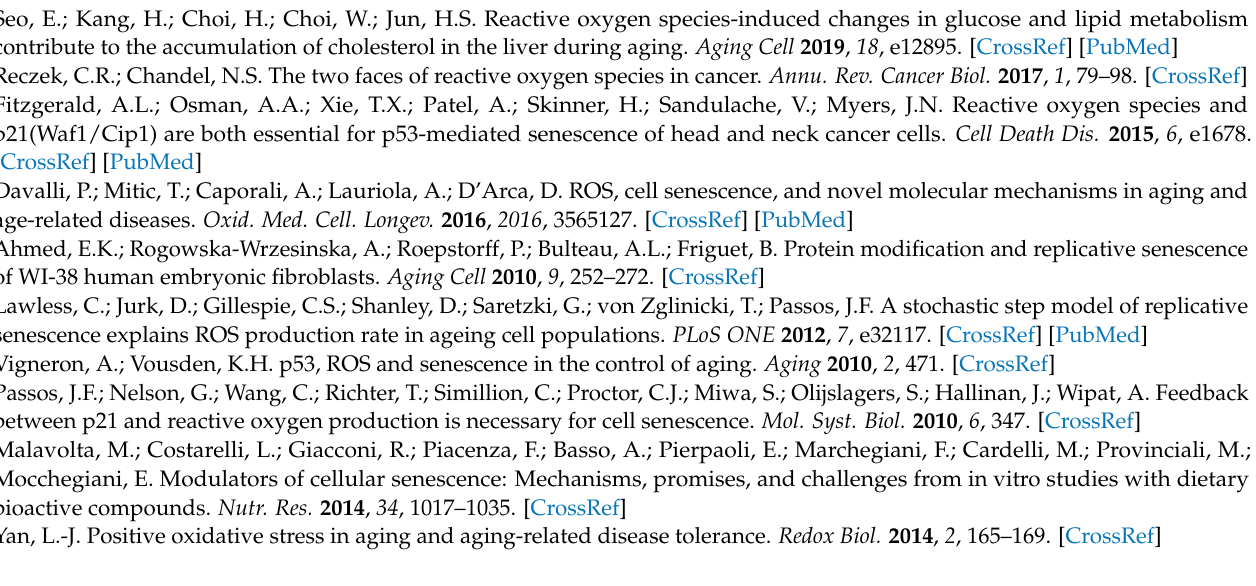
Table S2: Major liver metabolites from mice fed a HFD and C3G for 8 weeks using CE-MS and GC-TOF-MS. Figure S1: C3G modulates ROS and cell signalling in hepatocarcinoma cells. Figure S2: Several potential molecular pathways are involved in cellular senescence and C3G presumably regulates cell fate in an AMPK/p53-dependent